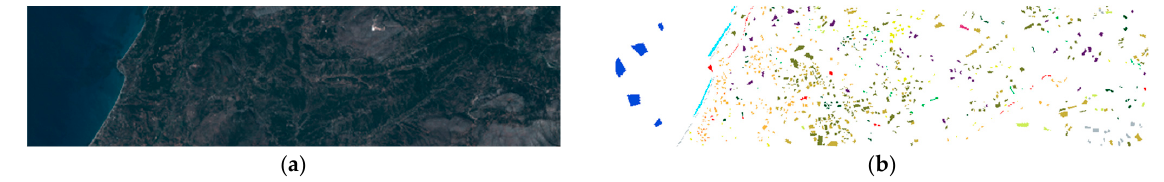
Figure 1. HL dataset false color images and ground truth. ( a ) three-band composite false color images (23, 11, 7); ( b ) ground truth.